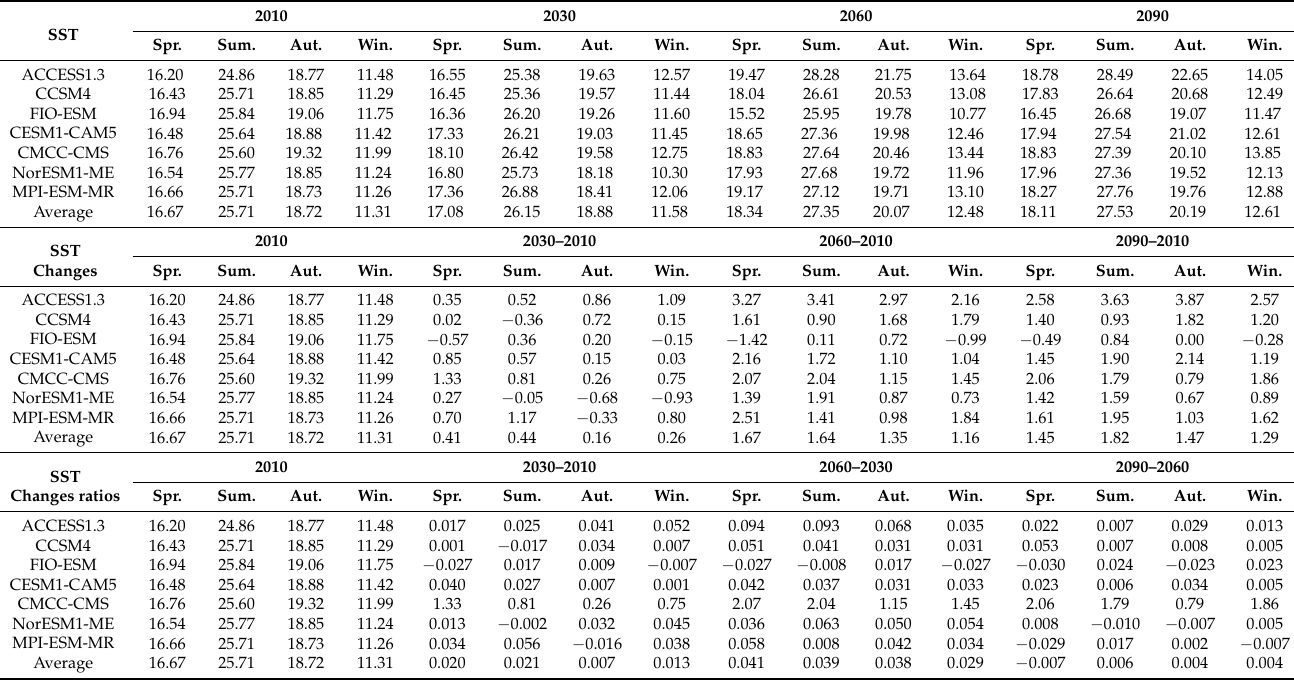
Table 4. The projection results of seasonal SST variations in the next 100 years using seven CMIP5 models and their average result.